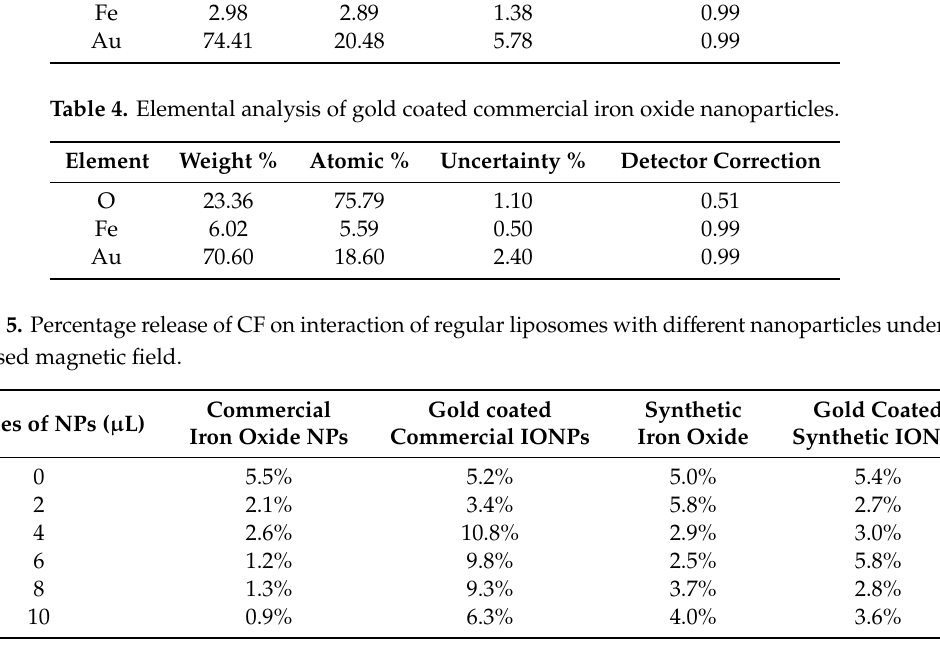
Table 6. Percentage release of CF on interaction of 50% Thiolated Cholesterol (Th-Chol) liposomes with di ff erent nanoparticles under pulsed magnetic